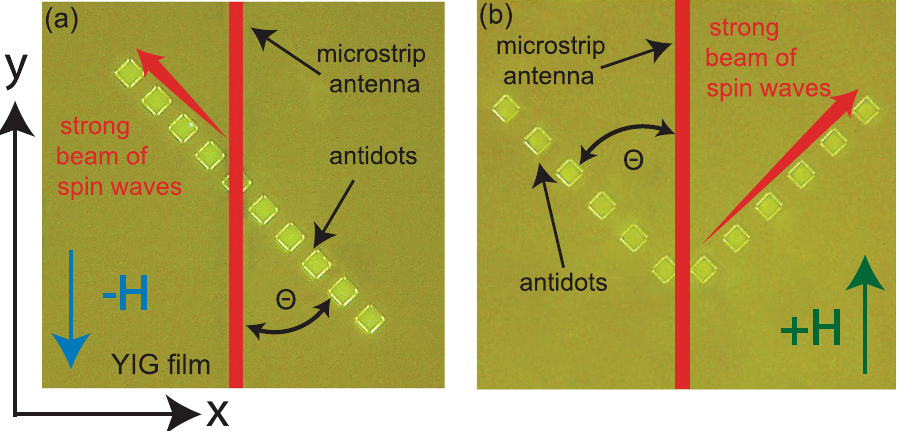
Figure 1. Photos showing the structures under investigation and demonstration principles of the two spin wave switchers. ( a ) 180° switcher, and ( b ) 90° V-type geometry switcher. Microstrip antenna (red vertical bar) placed on the surface of a YIG film under magnetic field H parallel to the antenna, and at the angle θ = 45° with respect to the line of square antidots. Microwaves in the antenna induce SWs propagating in the sample to the left ( a ) or right ( b ) with the field H in the negative or positive direction of the y -axis, respectively.